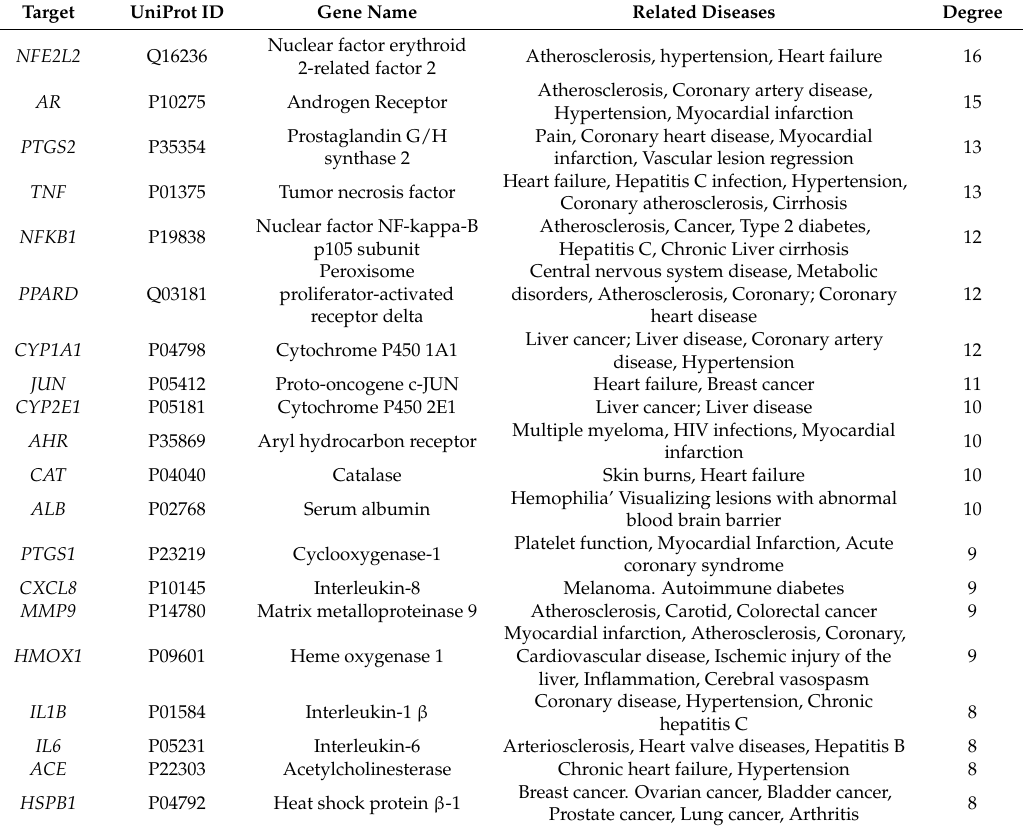
Table 4. TOP 20 Targets information of pungent TCMs in the cardiovascular